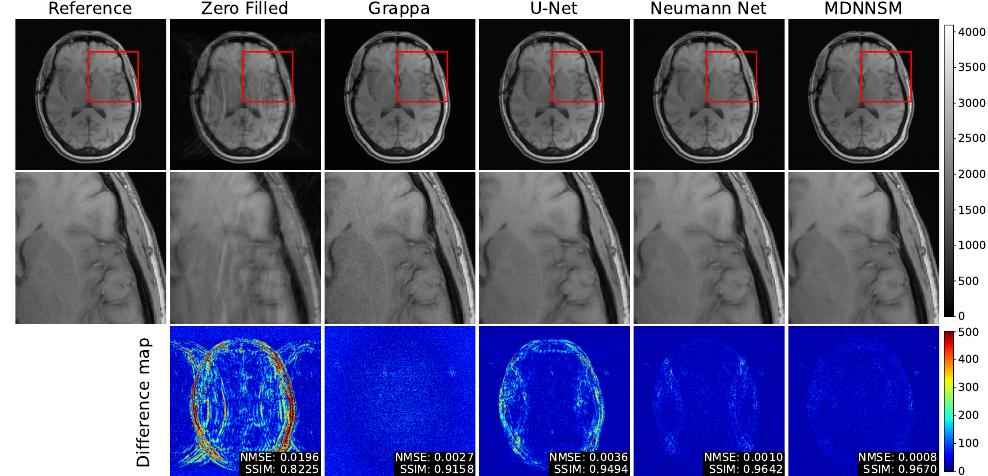
Figure 5. The top row shows fully sampled and reconstructed T1-weighted images using the zero- filled, Grappa, U-net, Neumann network, and MDNNSM methods, with an acceleration factor of 2 and an ACS rate of 10%. The middle row shows detailed images zooming the red box area of the top row. The bottom row shows the difference between the reference and reconstruction images. The MDNNSM showed the lowest NMSE and the highest